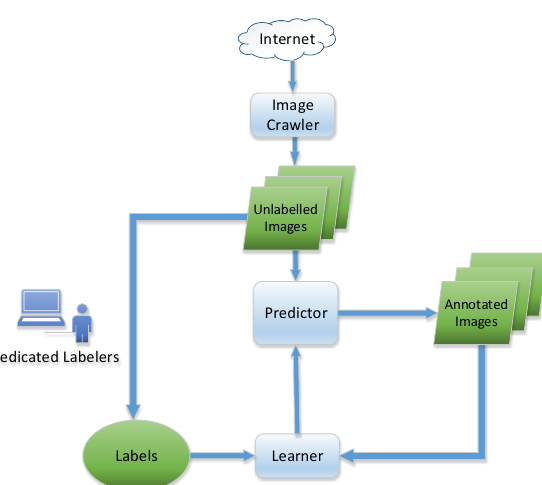
Figure 2. Illustration of the online scene classification framework. As time goes by, unlabeled images are assumed to arrive consecutively. A predictor is applied to annotate the images that have arrived. When the true label is revealed, the online learner updates the predictor for the next prediction.